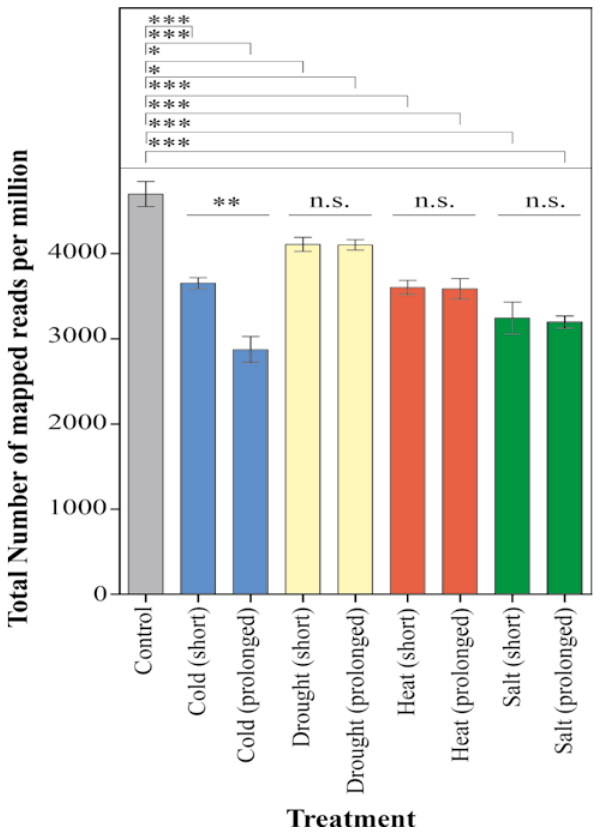
Fig. 1. Total number of mapped reads (per million of reads) on the 828 full-length LTR-REs of P. trichocarpa , in leaves of control and stress-exposed plants. Stresses included cold, drought, heat and salt treatments, for short and prolonged times. The differences between control and each treatment and between short and prolonged stress treatments were significant at p<0.001 (***), p<0.01 (**), p<0.05 (*), or not significant (n.s.) according to Tukey’s test.